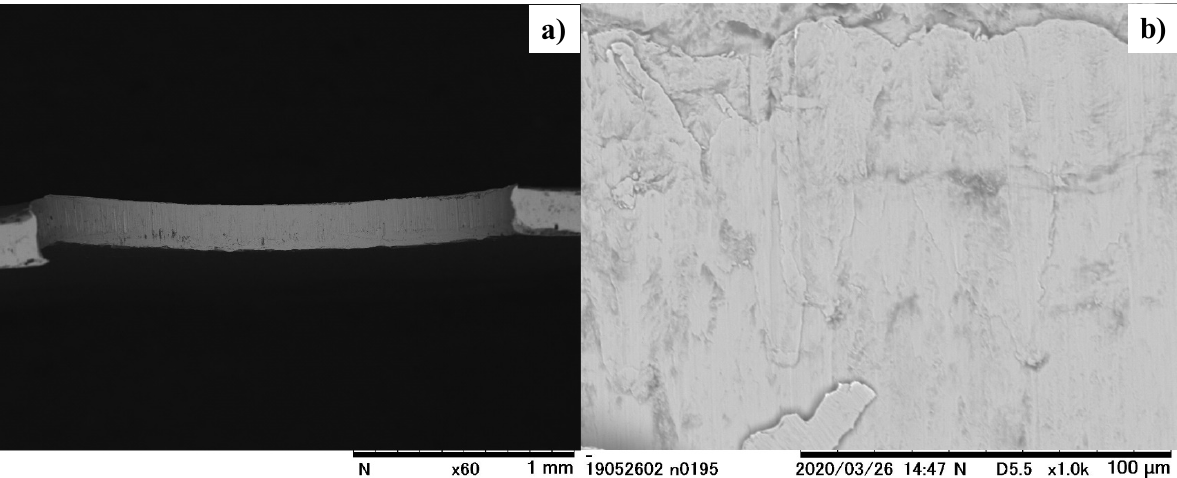
Figure 15. An electrical steel sheet perforated with the use of edge-sharpened and nano-textured SKD 11 punch. ( a ) Overall image of the pierced hole, and ( b ) fully burnished hole surface.